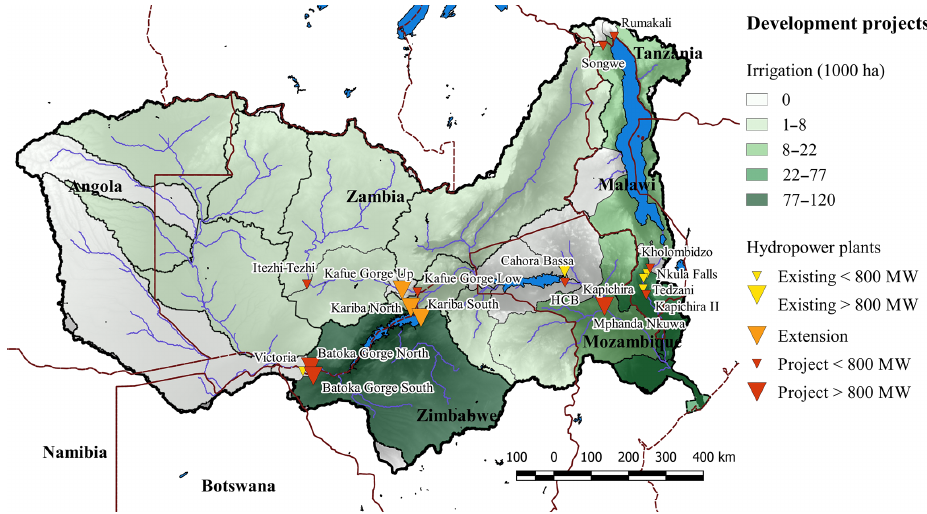
Figure 5. Hydropower and irrigation development projects. The major irrigation development projects are located at Kariba Lake (Zim- babwe), in the Zambezi Delta (Mozambique), and in the Lower Shire (Malawi). The major hydropower projects are Batoka Gorge North and Batoka Gorge South with 800MW in Zambia and 800MW in Zimbabwe, respectively, and Mphanda Nkuwa with 1300MW in Mozambique. Table 2. Hydropower development projects. For extension projects, the original and projected capacity are indicated. Songwe (I + II + III) is an aggregation of three cascade hydropower projects. Projects are taken from World Bank (2010), and investment costs are taken from IRENA (2013). Country